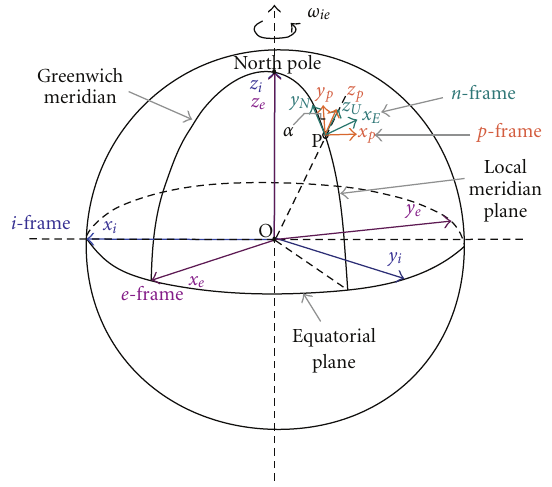
Figure 3: The reference frames.